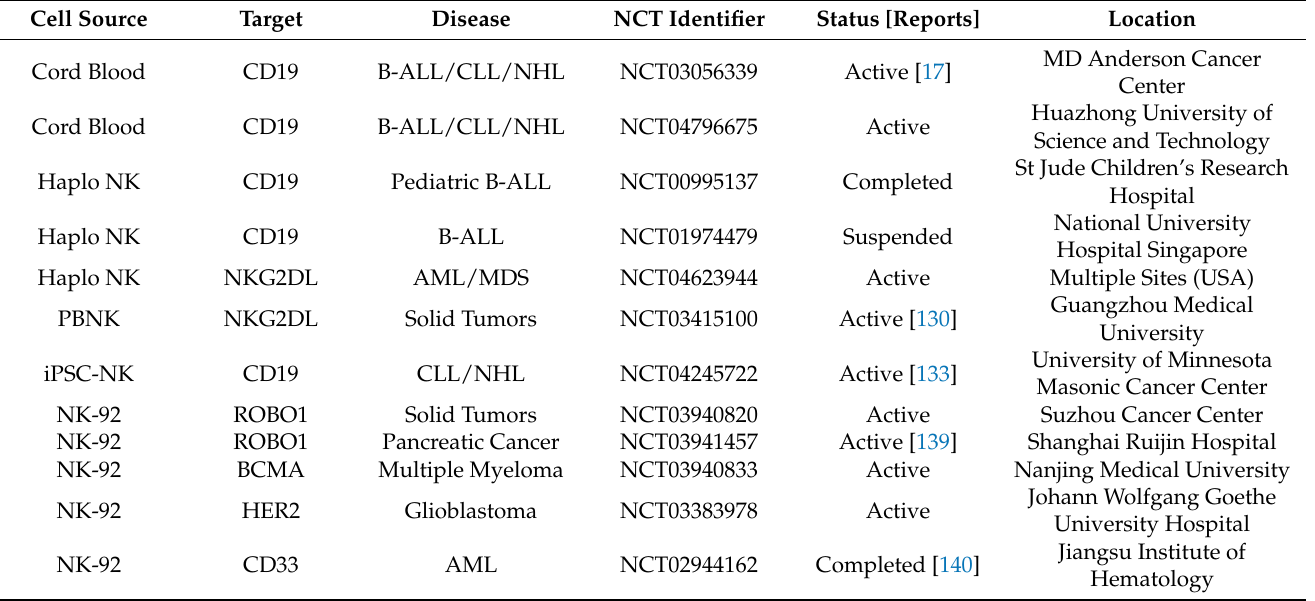
Table 2. Active and completed clinical trials of CAR-NK cell therapies. B-ALL = B-cell acute lymphoblastic leukemia, CLL = chronic lymphocytic leukemia, NHL = non-hodgkin lymphoma, AML = acute myeloid leukemia, MDS = myelodys- plastic syndrome, iPSC = induced pluripotent stem